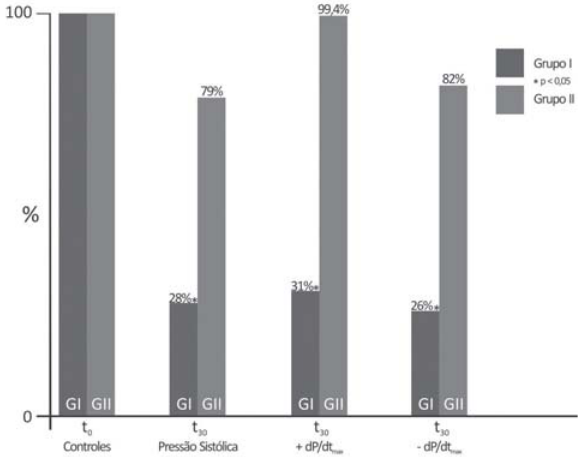
Fig. 1 – A: Isolamento da aorta para canulação; B: